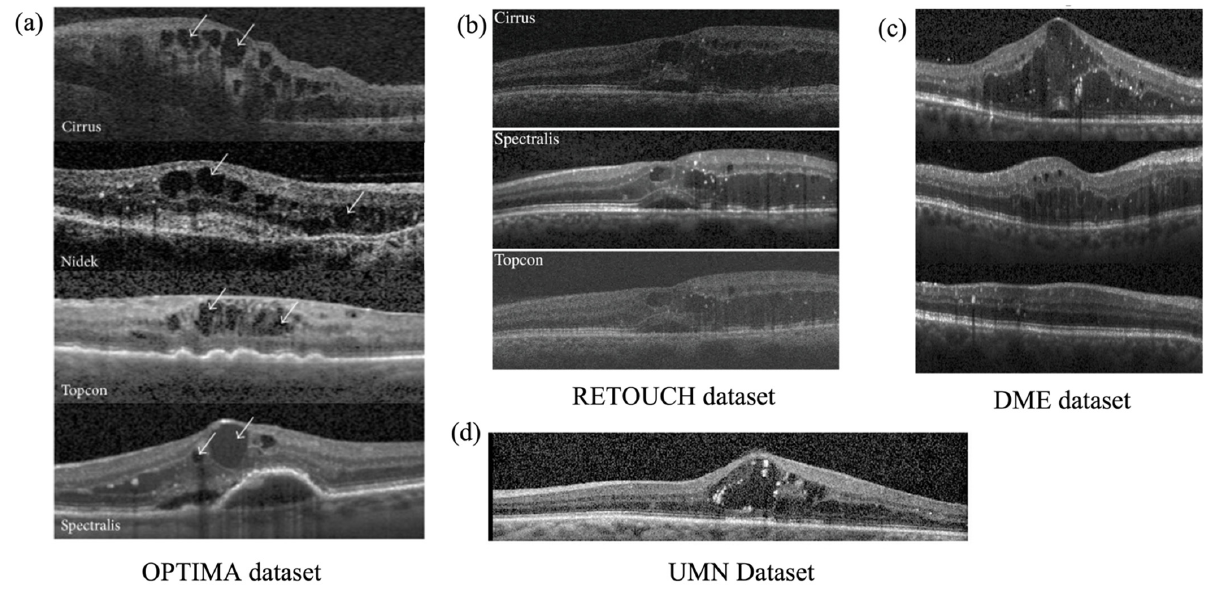
Figure 6. Sample OCT images from public datasets: ( a ) OPTIMA dataset [75]; ( b ) RETOUCH dataset [76]; ( c ) DME dataset [52]; ( d ) UMN dataset [77].